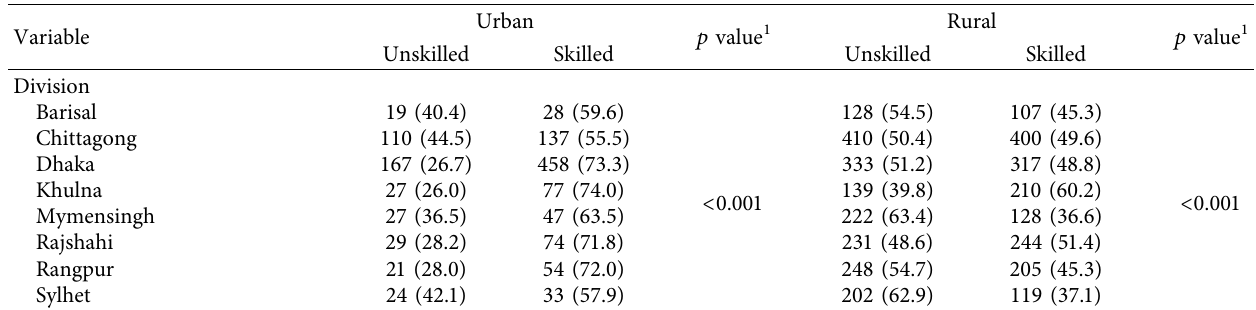
Table 2: Prevalence of skilled birth attended in terms of urban and rural area in Bangladesh for the selected predictors of